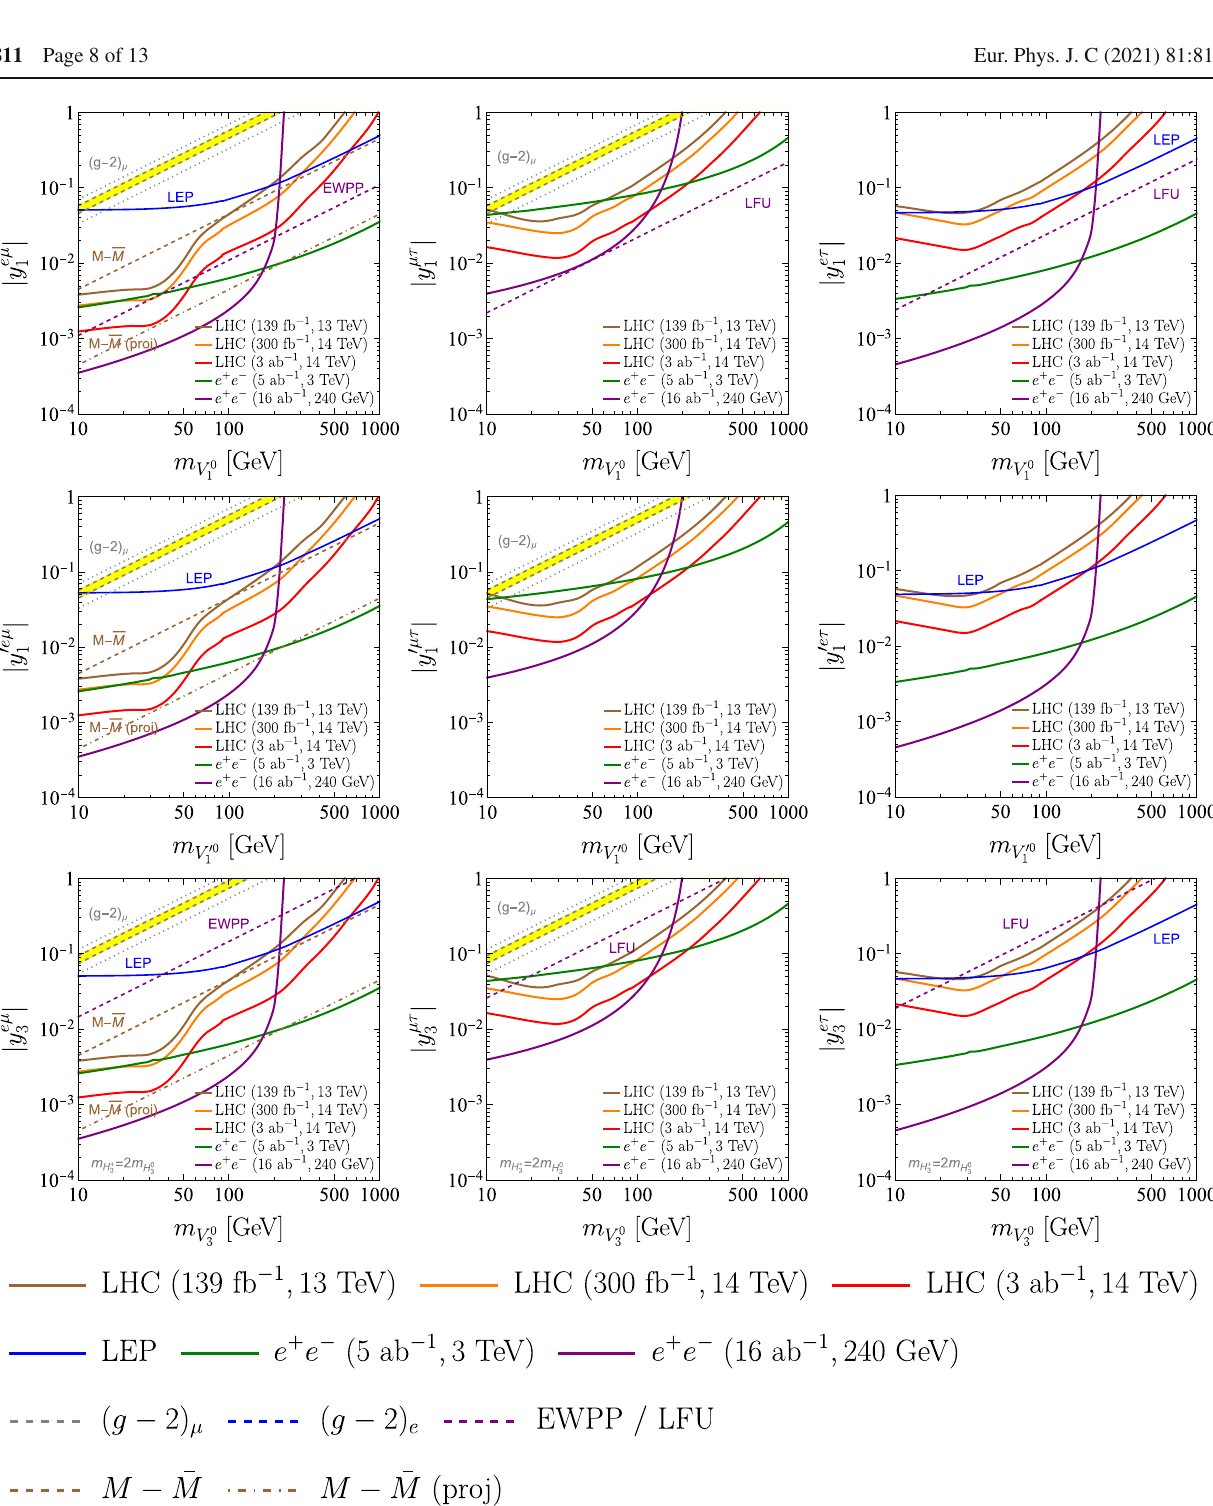
Other low-energy constraints are also shown. The brown dashed and dot-dashed lines are for muonium-antimuonium oscillation ( M − ¯ M ) constraint and MACE projection, respectively. Purple dashed lines are for the constraints from LFU or electroweak precision physics (EWPP). The LEP bound is shown using blue solid